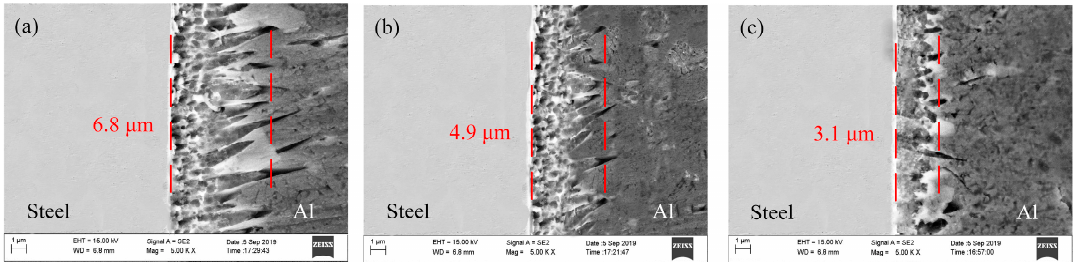
Figure 12. Microstructure of the IMCs layer with different welding speed: ( a ) 0.8 m/min; ( b ) 1.0 m/min; ( c ) 1.2 m/min.